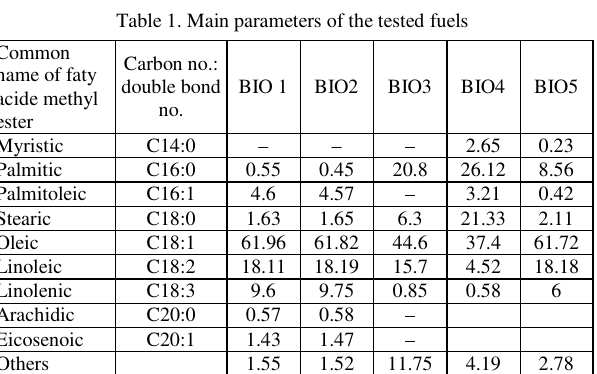
Table 1. Main parameters of the tested fuels